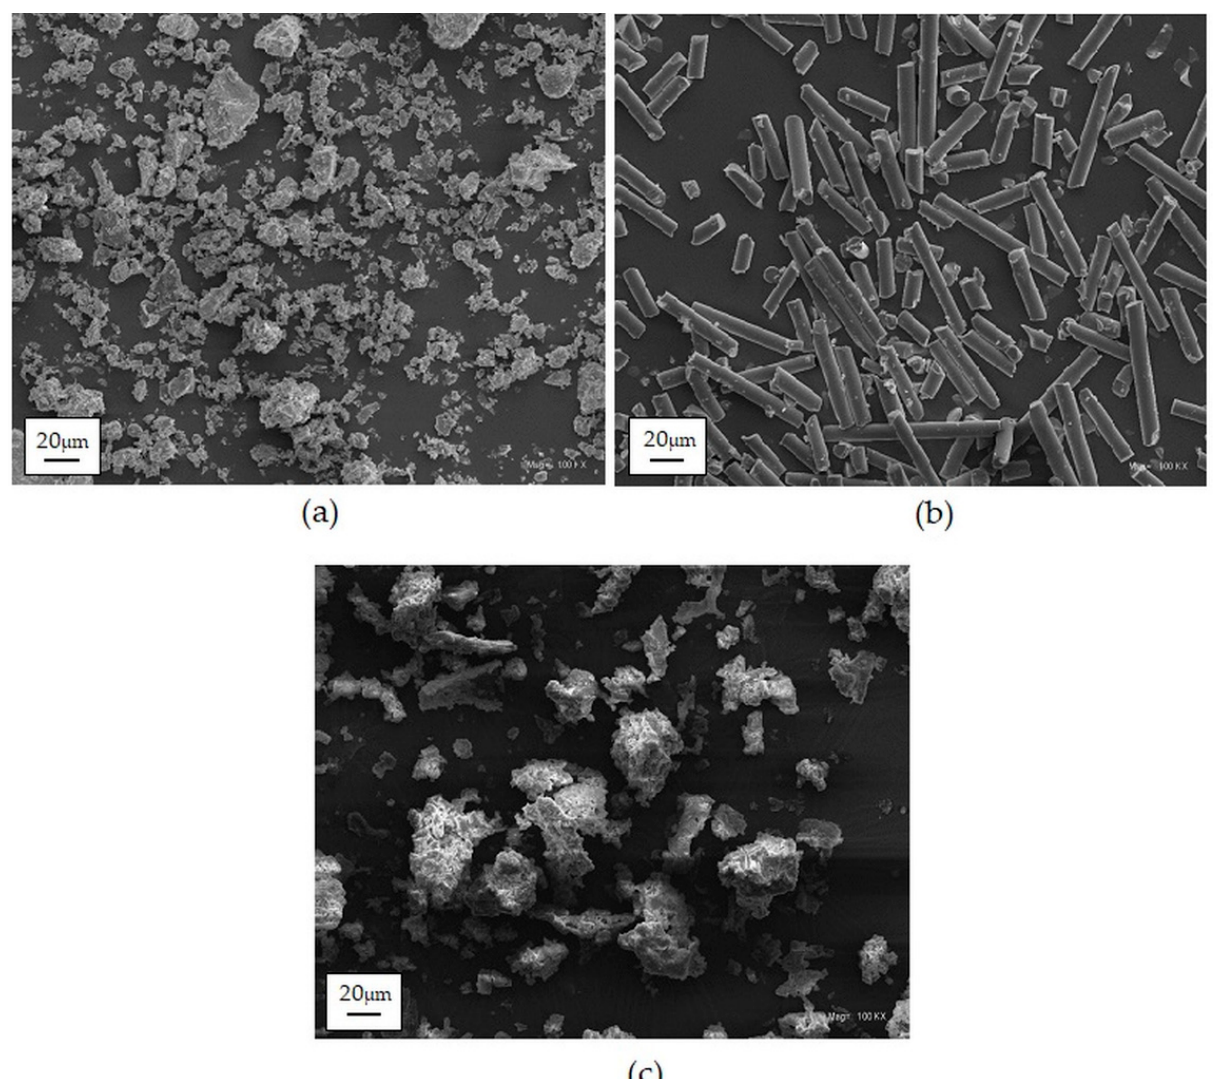
Figure 2. SEM images of the fillers: ( a ) basalt powder, ( b ) basalt micro fiber, ( c ) sunflower husk ash.